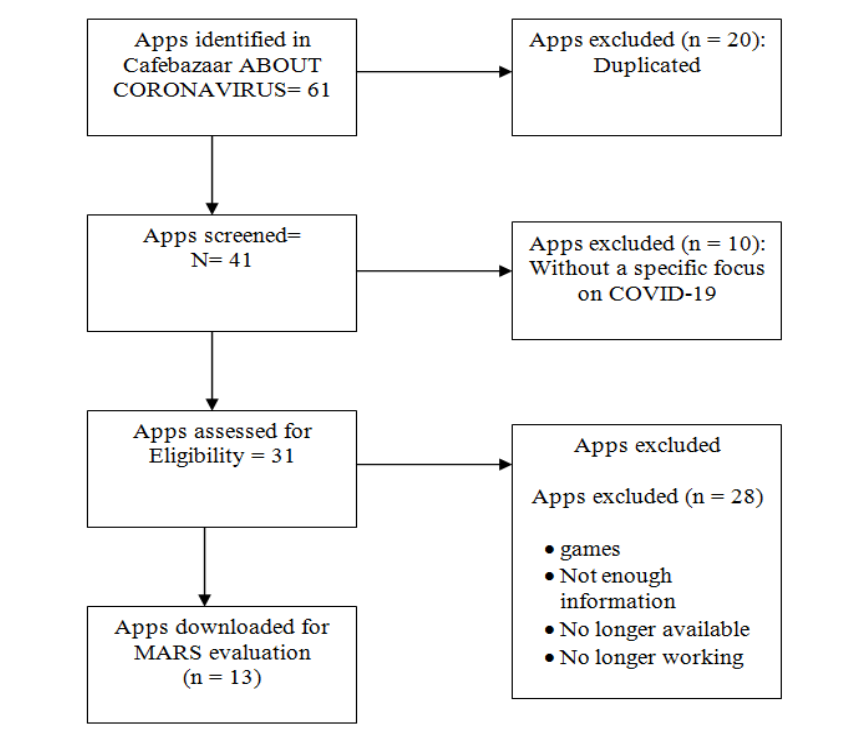
Fig1. Systematic search of Coronavirus